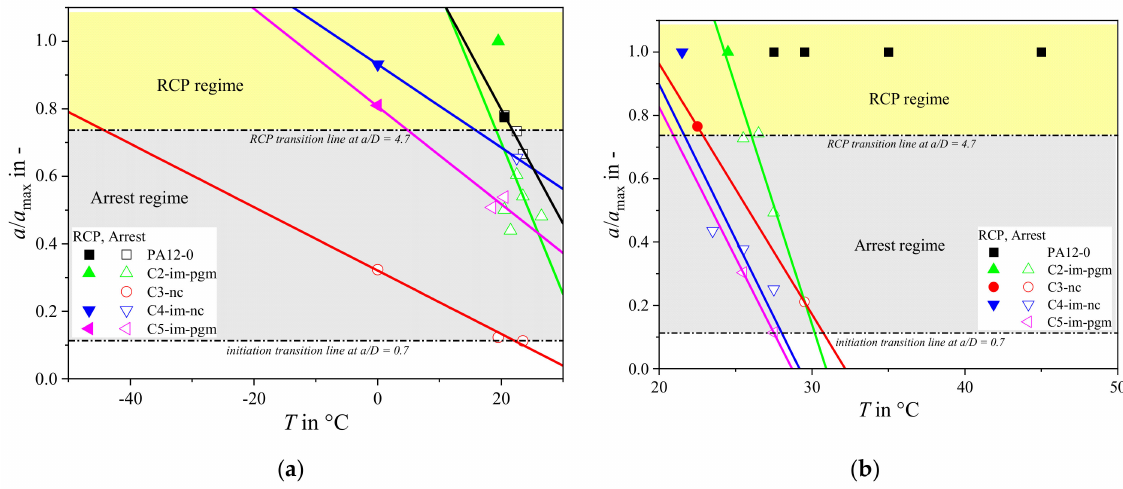
Figure 5. Modified evaluation of the critical temperature values of all grades at ( a ) 5 bar and ( b ) 12 bar.